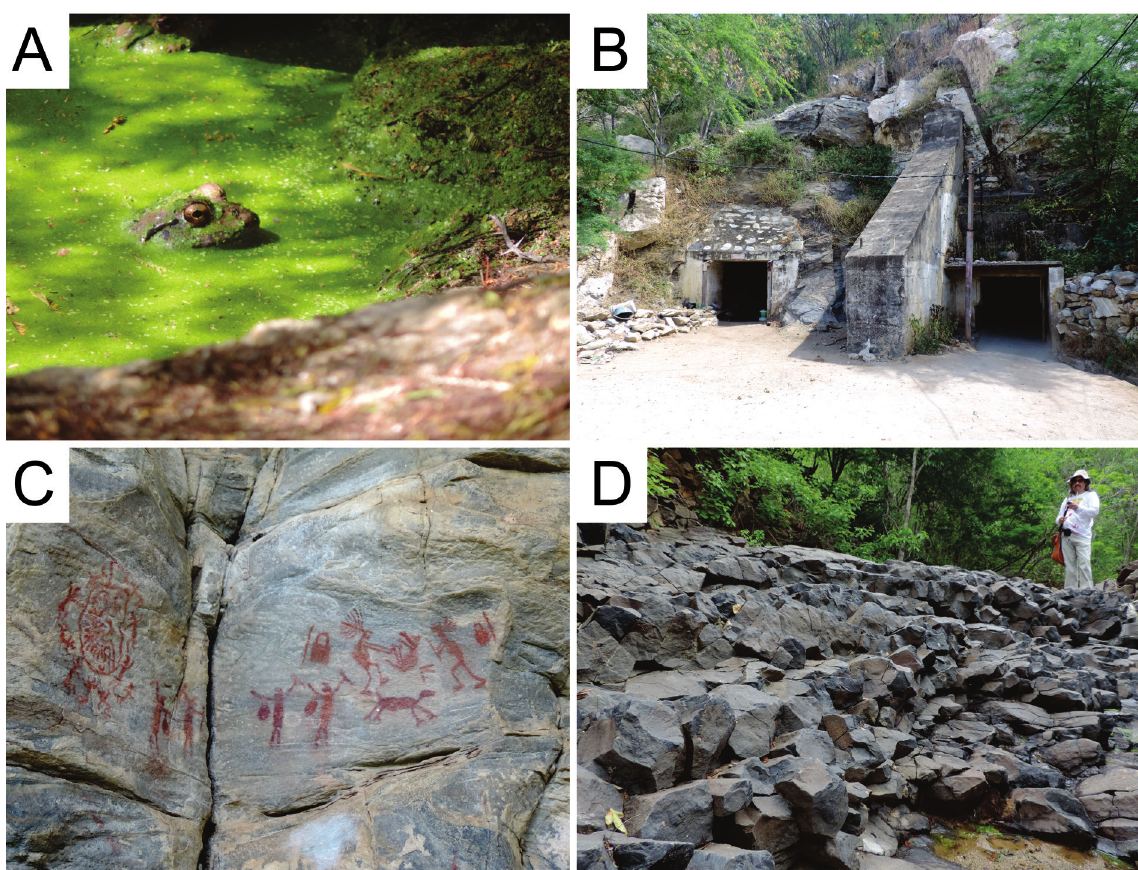
Figure 4. A) Frog found in pond on Serra Verde geosite, which evidences a regulating service (habitat provision). B) Entrance of Brejuí Mine geosite, that provides a provisioning service (industrial minerals). C) Rock painting on a quartzite in the Xiquex- ique geosite, an example of cultural service (historic meaning). D) Horizontal columnar disjunctions, an evidence of a Cenozoic volcanism that can be used for education, a knowledge service. Photos: Matheus